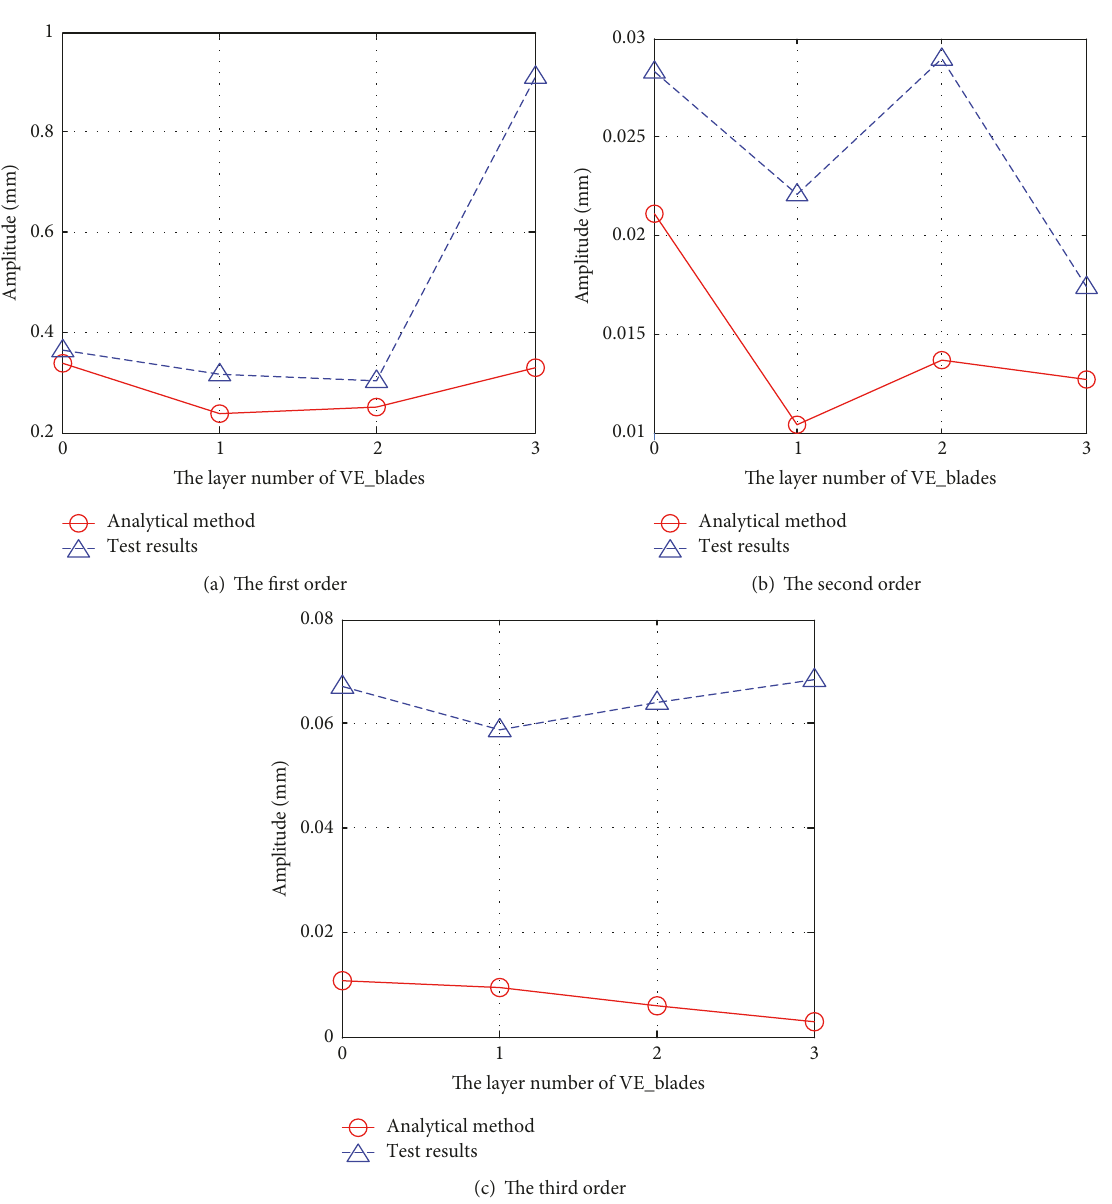
Figure 6: Comparison of experimental results (solid line with circle) and simulation results (dotted line with triangle) of resonant response of VE-blade.